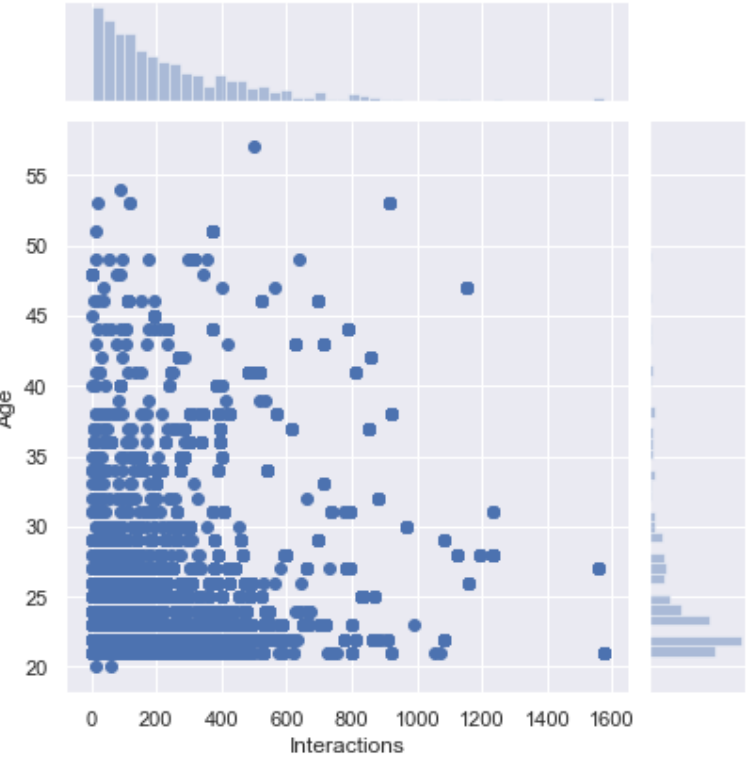
Figure 3. Dispersion between interactions and